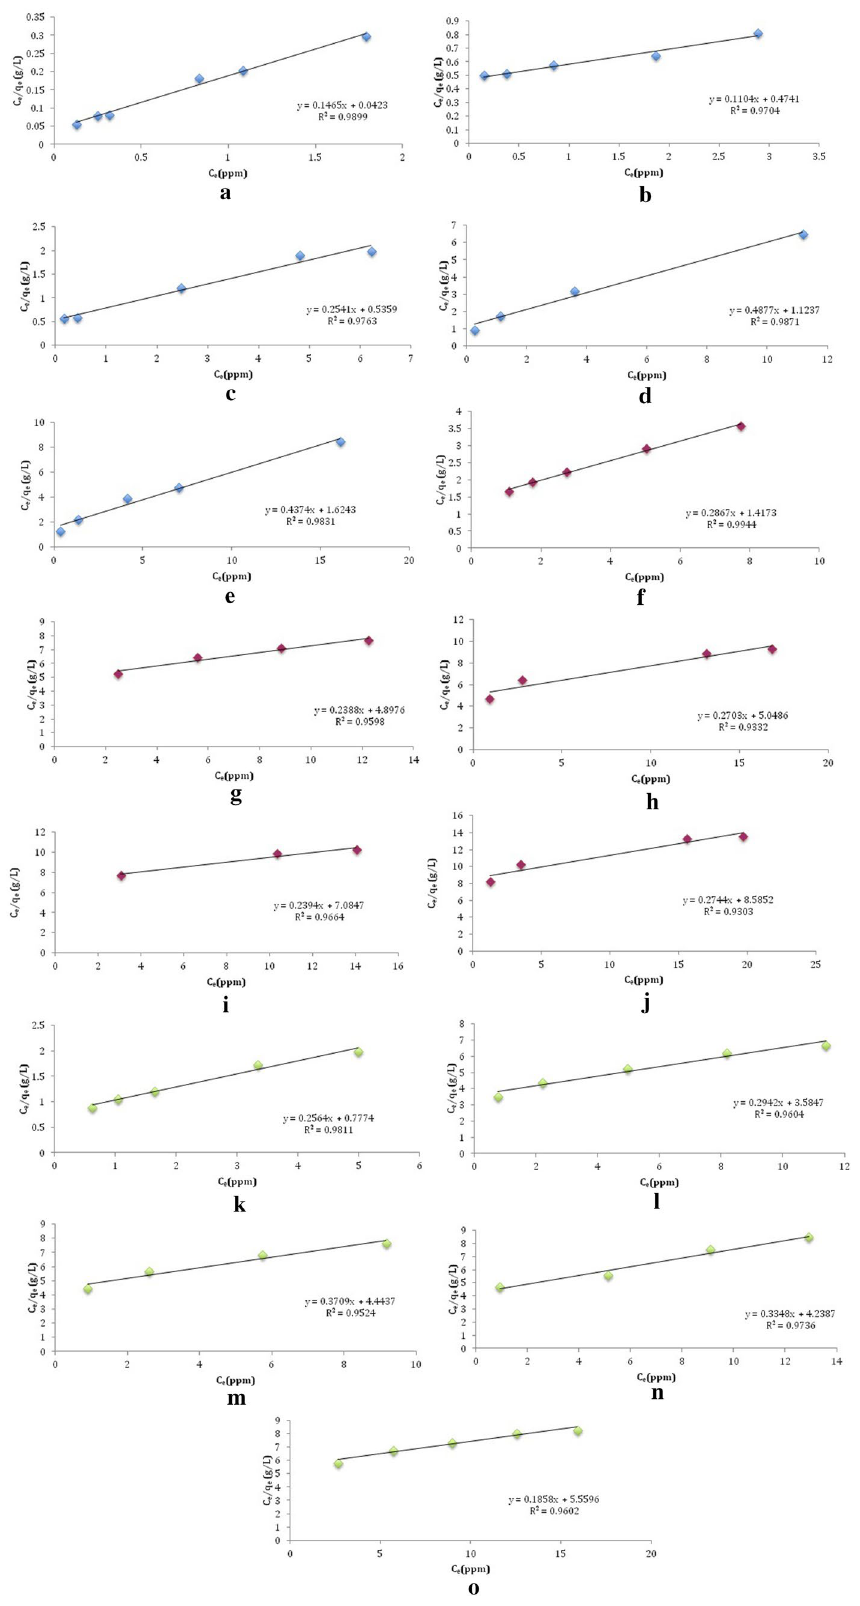
Figure 3. Langmuir isotherm for the biosorption of the following ( a ) Pb(II) onto ZSC–KOH; ( b ) Pb(II) onto ZSC–citric acid; ( c ) Pb(II) on to ZSC–H 2 SO 4 ; ( d ) Pb(II) onto ZSC–HCl; ( e ) Pb(II) onto ZSC–H 2 O 2 ; ( f ) Zn(II) onto ZSC–KOH; ( g